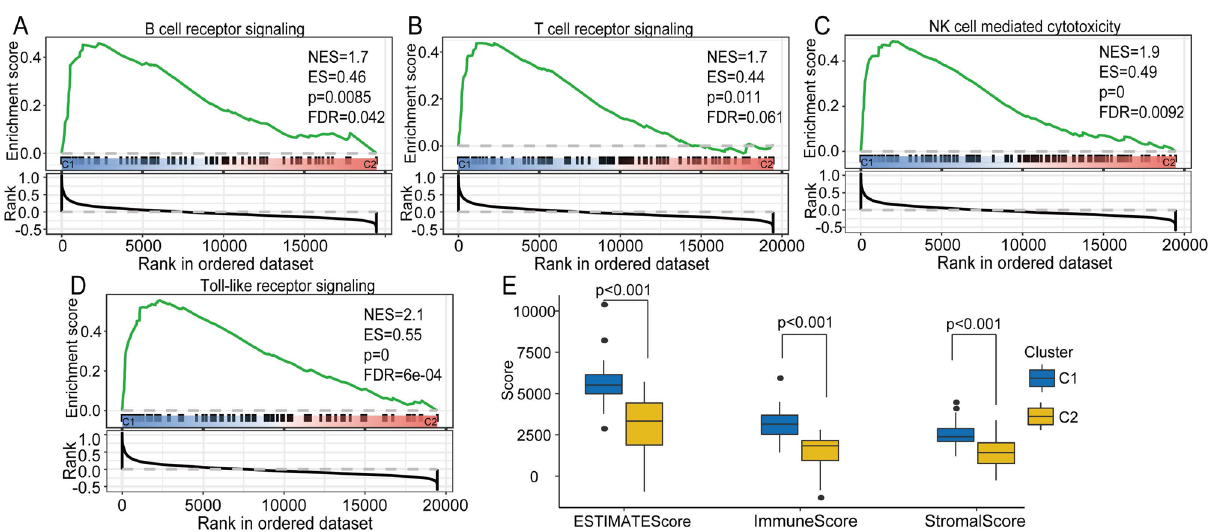
Figure 3. Immune system-related pathway analyses and evaluation by group subtype. ( A – D ) KEGG analysis of immune system-related pathways showed enrichment of the B cell receptor signaling pathway, the T cell receptor signaling pathway, natural killer cell-mediated cytotoxicity pathways, and the Toll-like receptor signaling pathway. ( E ) Comparisons of stromal score, immune score, and estimate score between the C1 and C2